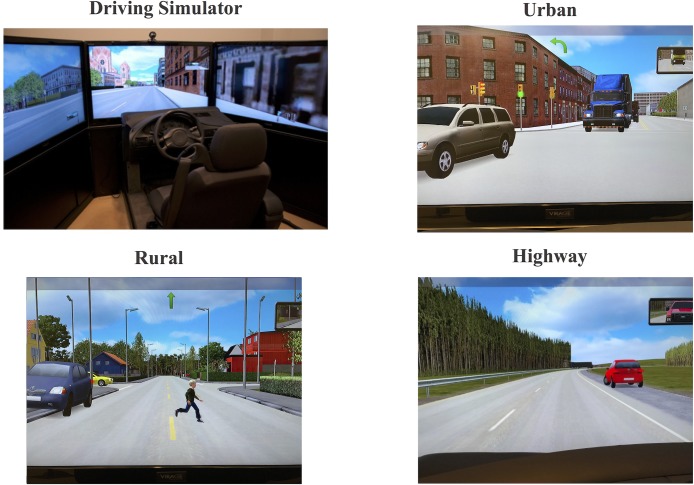
Image of the VS500M driving simulator and example of events belonging to the single visible conflict category within the Urban, Rural and Highway scenario.The event displayed on the top right panel (i.e. Urban scenario) corresponds to a cyclist violating the red light. During the events displayed in the bottom left panel (i.e. Rural scenario) and in the bottom right panel (i.e. Highway scenario) a car gets out of the drive-way and comes into the trajectory of the participant's car. These three events differed slightly to avoid participants’ anticipation but belong to the same category of events. Each panel corresponds to a photograph of the simulator’s central screen.